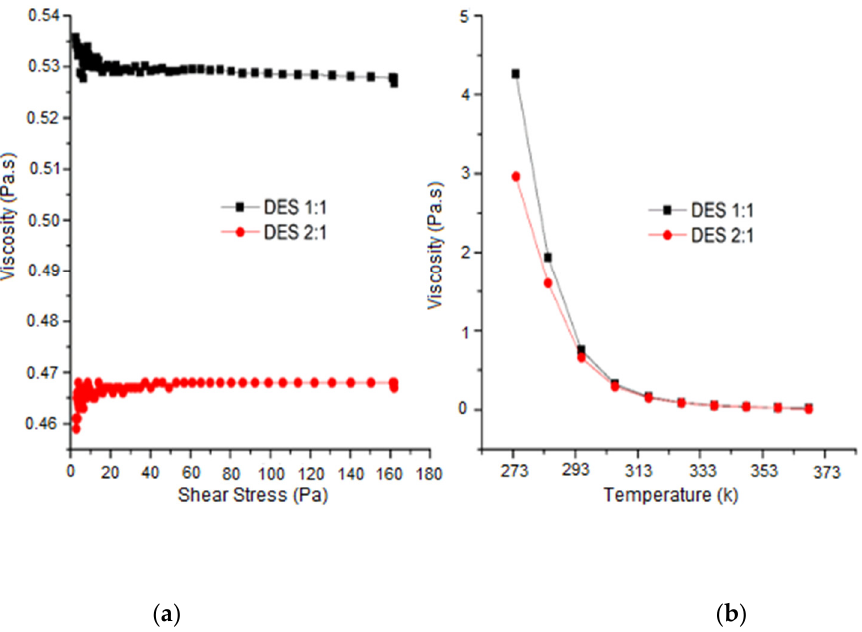
Figure 2. ( a ) Viscosity of DES [MgCl 2 · 6H 2 O][U] as a function of shear stress ( b ) and temperature. DES (1:1) achieved the highest viscosity value at 25 °C (0.535 Pa.s), whereas DES 2:1 presented a slightly lower value of 0.4623 Pa.s.